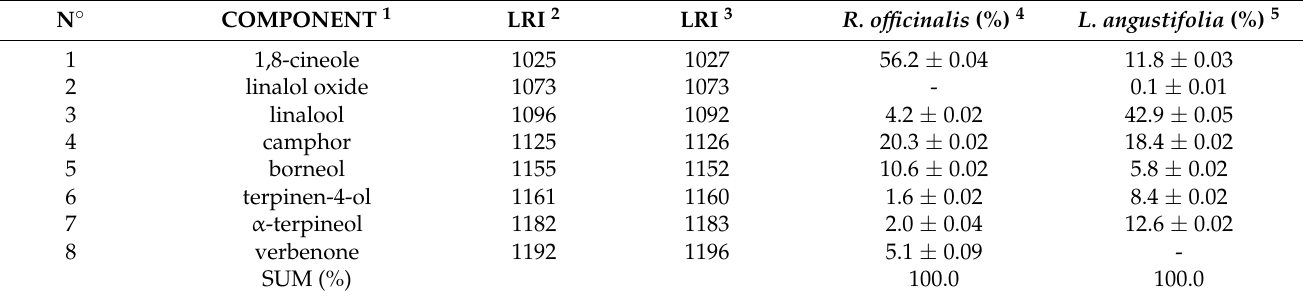
Table 3. Chemical composition (%) of vapor-phase R. officinalis and L. angustifolia